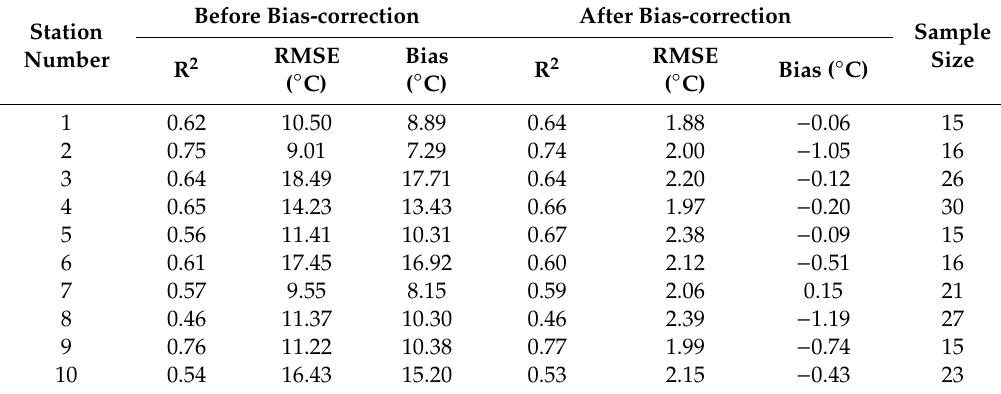
Table A1. The relationship between clear sky MODIS LSTs and the before-and-after 1 km bias-corrected in situ LSTs during July and August from 2013 to 2018 for the 10 stations in daytime. Refer to Figure 1 for station